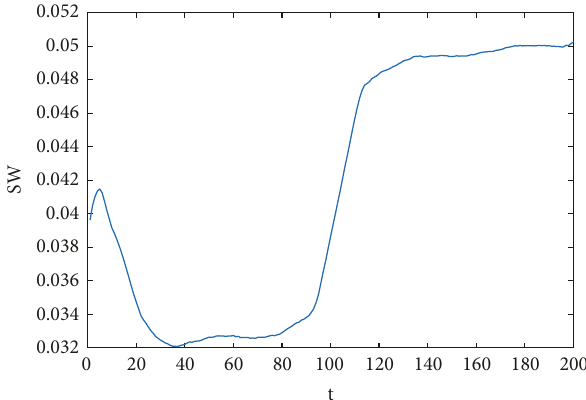
Figure 4: The evolution picture of the collaborative innovation network small-world Q.